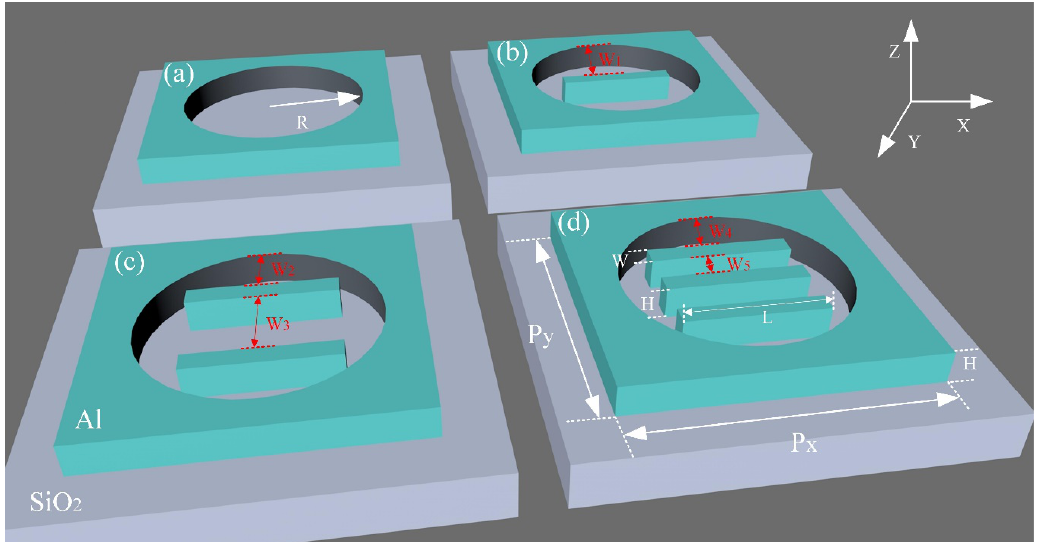
Figure 1. Structural cross-sectional diagram of the unit structure in the X - Y plane. R represents the circular structure radius; H is the thickness of the Al; L and W are the length and width of the metal strip; W (1–5) are the distance between metal strips; P x and P y are the periods; As follows: H = 50 nm; L = 100 nm; W = 10 nm; P x = P y = 200 nm; W 1 = 75 nm; W 2 = 30 nm; W 3 = 80 nm; W 4 = 30 nm; W 5 = 35 nm; ( a ) Hollow circular hole; ( b ) one metal strip; ( c ) two metal strips; ( d ) three metal strips; the metal strips